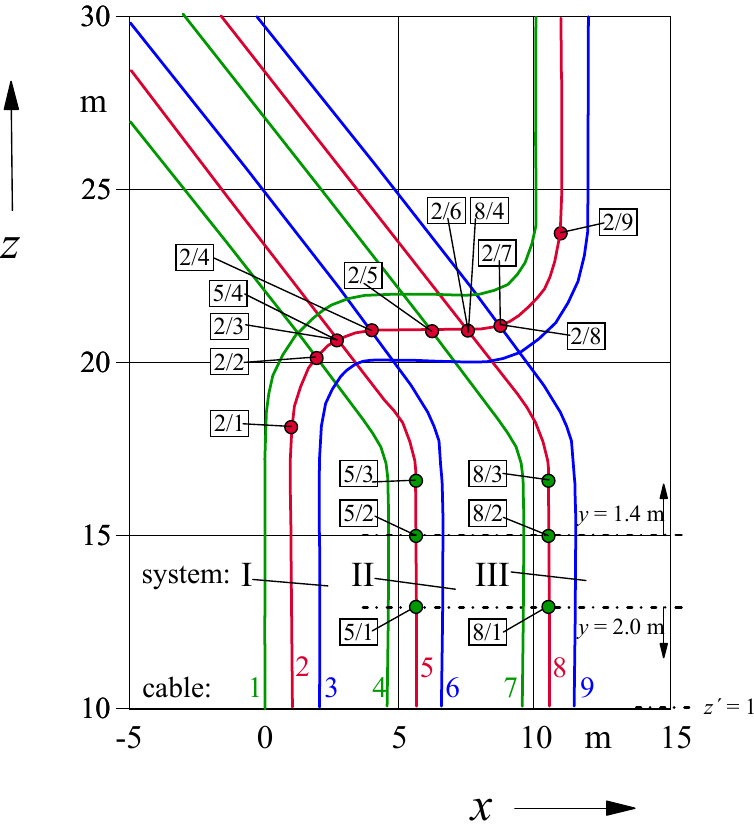
Figure 12. Crossing area with complex arrangement of nine 220-kV-XLPE-cables (3 × 3 × 1 × 2500 mm 2 copper; 60 Hz) with a laying depth of y = 2.0 m for z < 13.0 m; cables 4…9 are rising between z = 13.0 m…15.0 m from y = 2.0 m to y = 1.4 m; distance of axes in all systems: 1.0 m; current in all cables: 1600 A (15 °C; 1.0 W/(K m)).